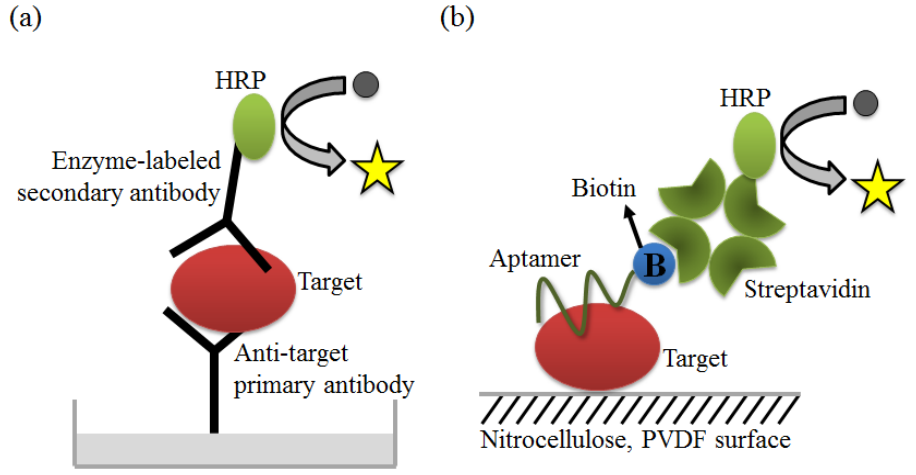
Figure 9. Schematic illustrations of ( a ) the ELISA method; and ( b ) the ALISA